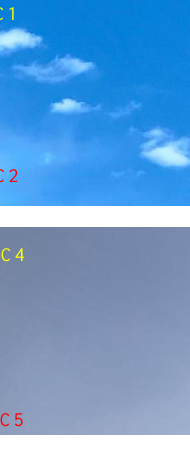
Figure 7. Misclassified images on the GCD dataset. Ground truth is represented by yellow labels, and predicted cloud types are indicated by red